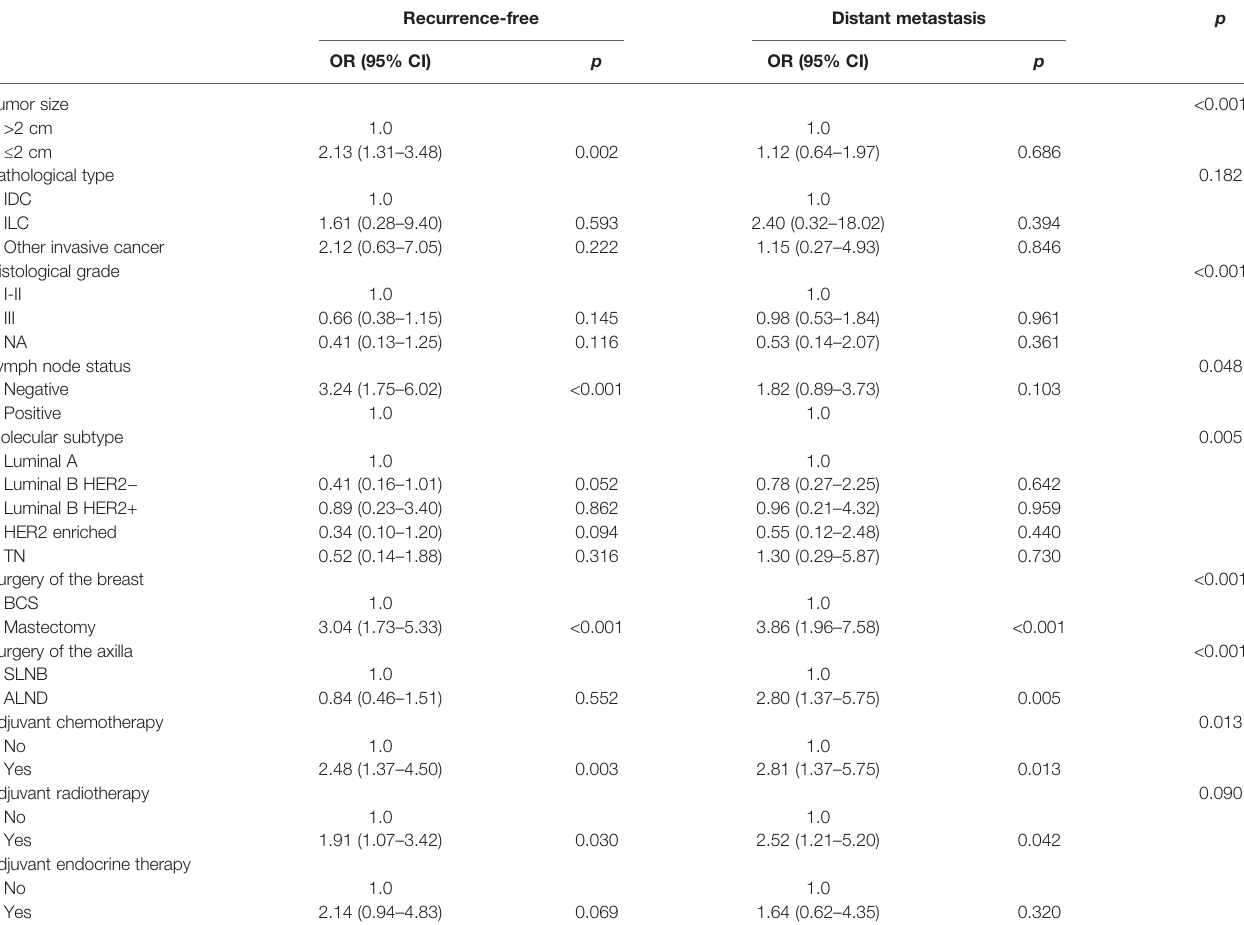
TABLE 2 | Multivariate logistic regression of predictors for disease recurrence type*. Recurrence-free Distant